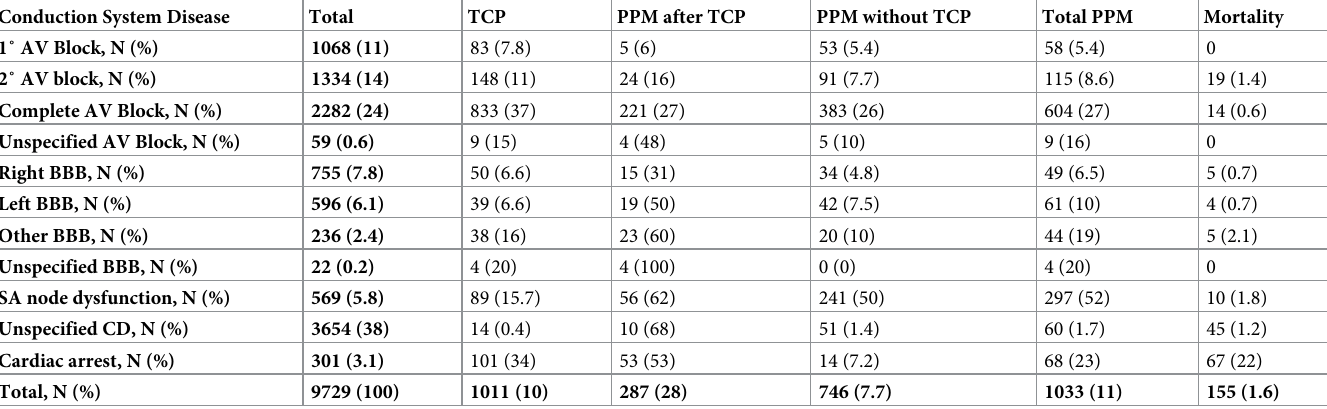
Table 3. Conduction system disease and pacemaker implantation in patients hospitalized with Lyme carditis in the U.S. between 2003 and 2014.